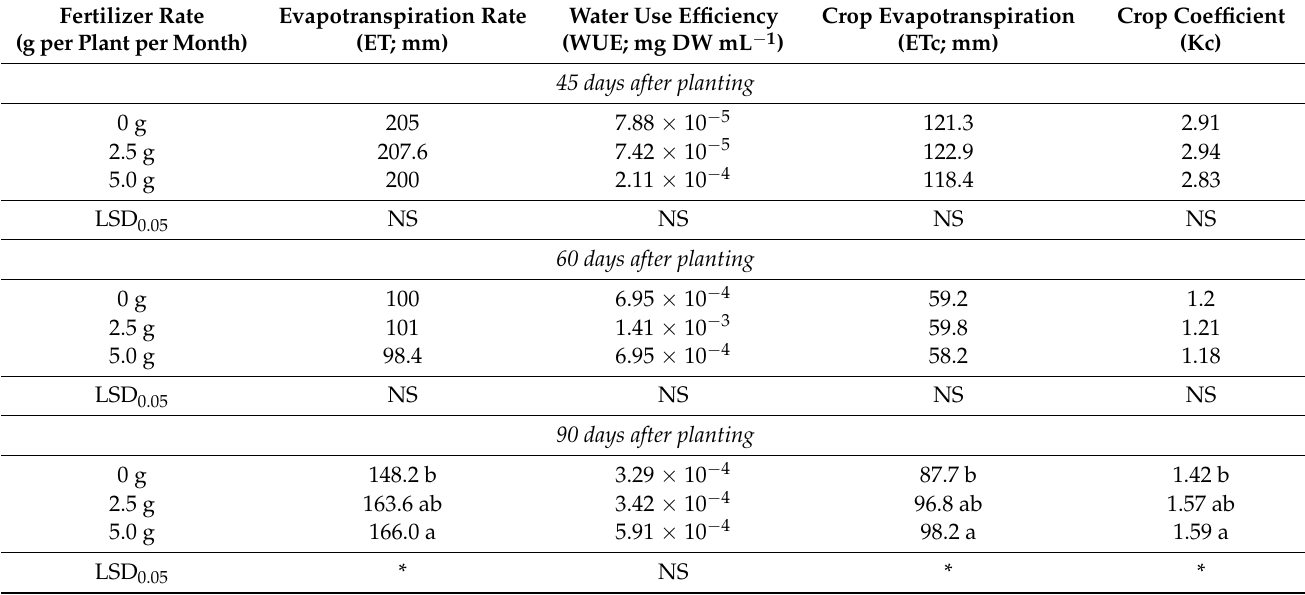
Table 3. Effects of fertilization rates on the evapotranspiration rates, water use efficiency, crop evapotranspiration, and crop coefficient of Hippeastrum ‘Red Lion’ at different growing